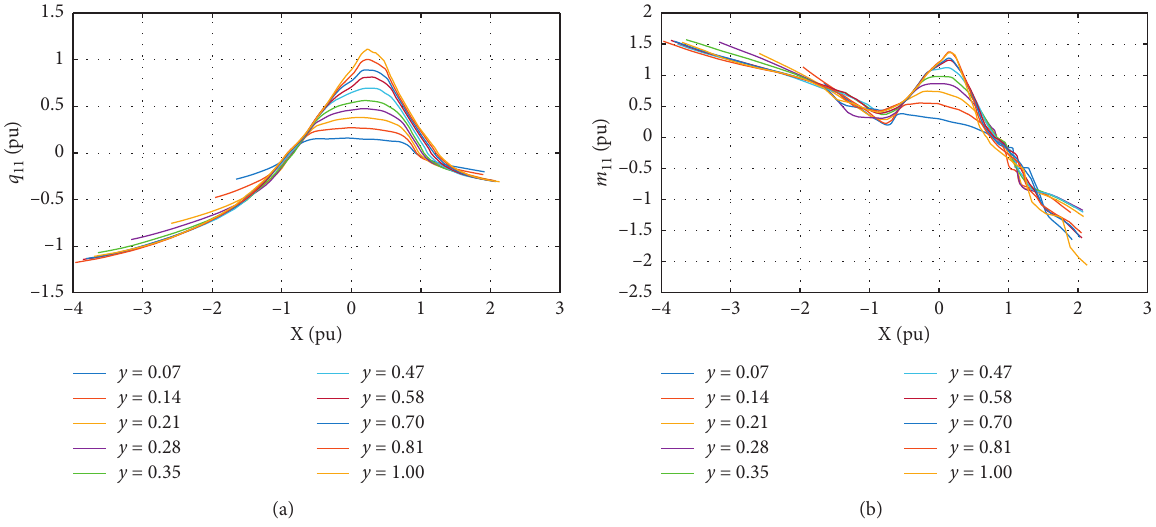
Figure 5: LCP of the characteristic curves. (a) Flow characteristic curve. (b) Moment characteristic